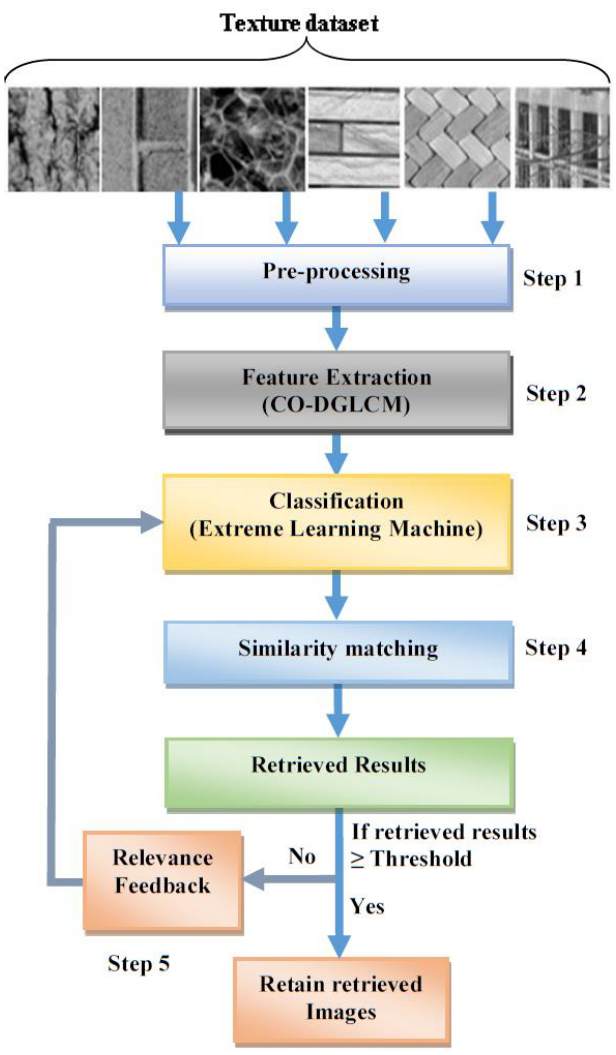
Figure 4. The architecture of the proposed system Phase 2: Feature Extraction and Normalization This second phase of the proposed system is based on the extortion of image features with the help of Discrete wavelet transform (DWT) and wavelet coefficients are obtained and the resultant matrix is formed. Then Gray level Co-occurence matrix (GLCM) feature vector with four angle directions